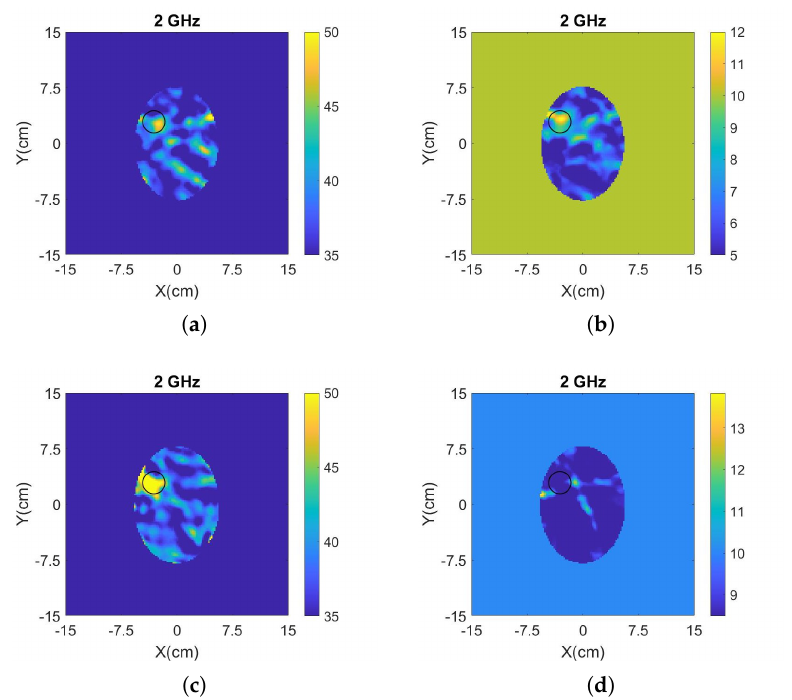
Figure 8. ( a ) Reconstructed real and ( b ) imaginary part of the complex permittivity for the phantom inside the tank of Figure 4b, when “no-target” and “h-stroke target” measurements were conducted at day 1 and day 6 after the preparation of phantom, respectively. ( c ) Reconstructed real and ( d ) maginary part of the complex permittivity for a two-layer phantom with an “h-stroke target” and a CSF layer which is unknown to the imaging algorithm. The complex permittivity was calculated at 2 GHz using a frequency hopping approach in 1.1–2